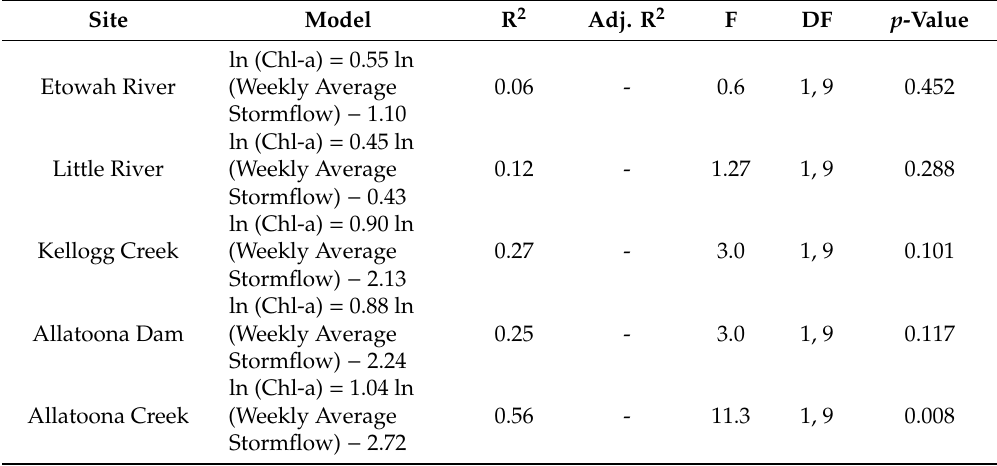
Table A2. Lake Allatoona Chlorophyll-a As a Function of Weekly Average Stormflow. Site